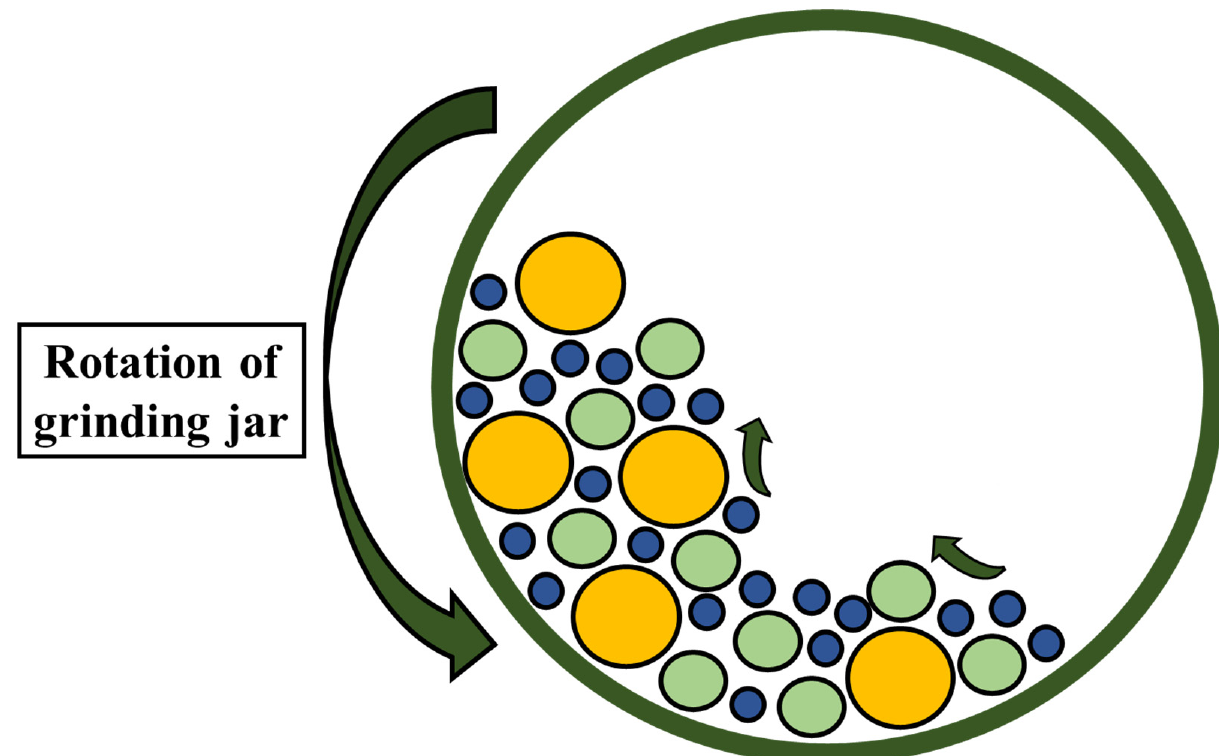
Figure 4. Schematic for planetary ball mill.